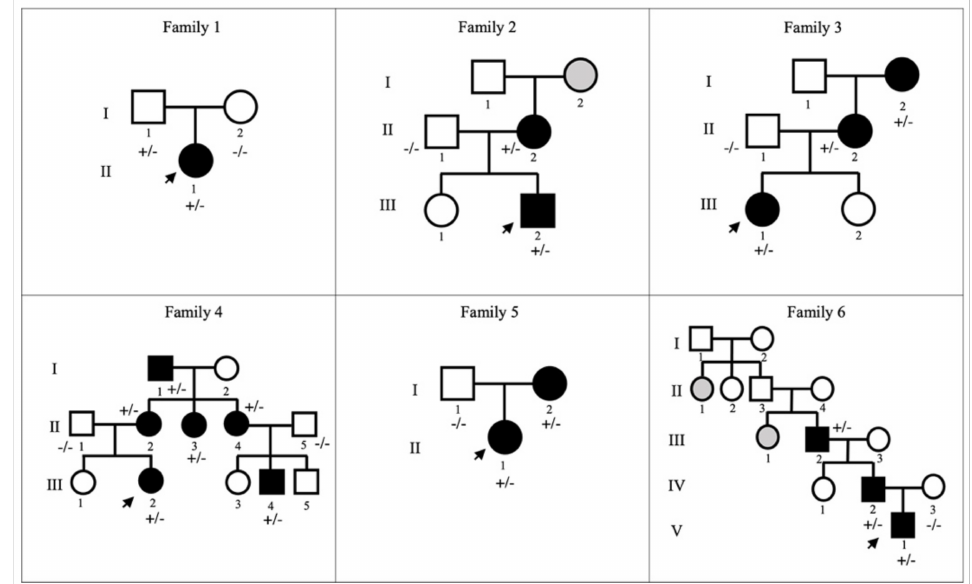
Figure 2. Pedigree of the familial cases with GLUT1DS. In family 2 and family 6, grey fills denote patients with clinical phenotype but unavailable for the